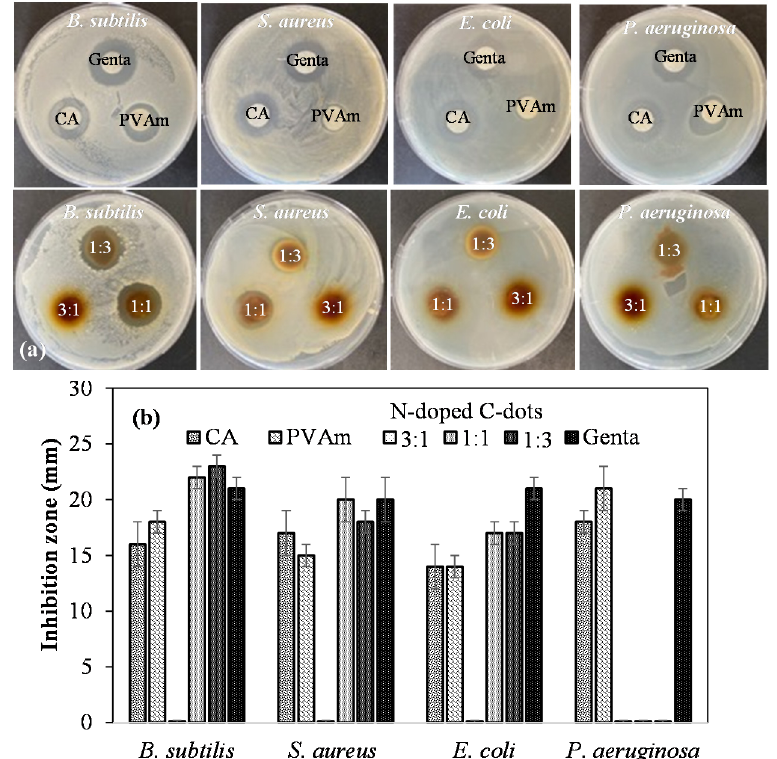
Figure 6. ( a ) Photographs of 50 μ L, 100 mg/mL (5 mg) CA, PVAm, and N-doped C-dots at three ratios of 3:1, 1:1, and 1:3 against B. subtilis, S. aureus, E. coli , and P. aeruginosa according to disc dif- fusion assay and ( b ) their inhibition zone diameters (mm). Gentamicin at 20 μ L, 1 mg/mL (0.02 mg) was used as a